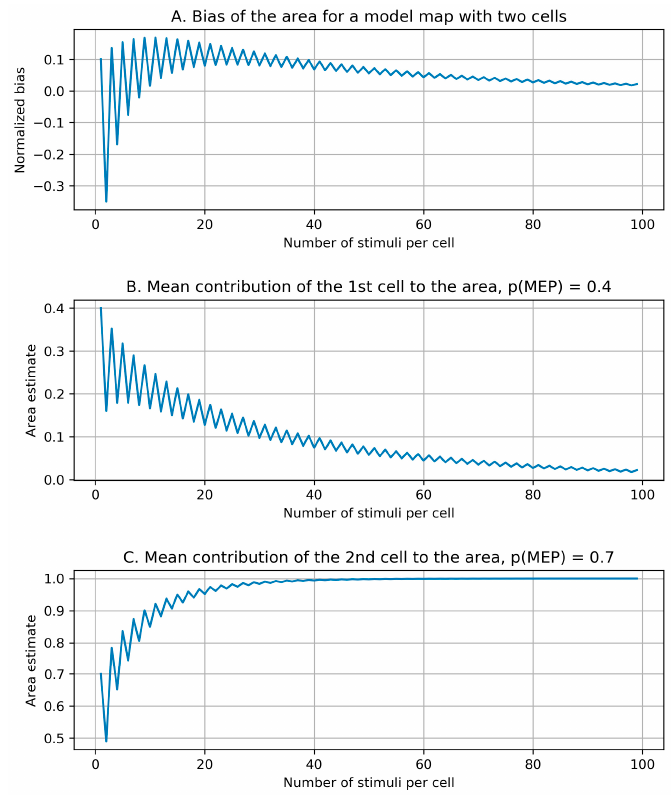
Figure A6. ( A ) Non-monotonic dependence of the bias of A half (the area of the cells with more than half suprathreshold MEPs) on the number of stimuli per cell. The bias is calculated for a model muscle representation consisting of two grid cells with the probabilities of suprathreshold MEPs equal to 0.4 and 0.7. ( B ) Contribution of the first cell to the estimate of A half . ( C ) Contribution of the second cell to the estimate of A half .